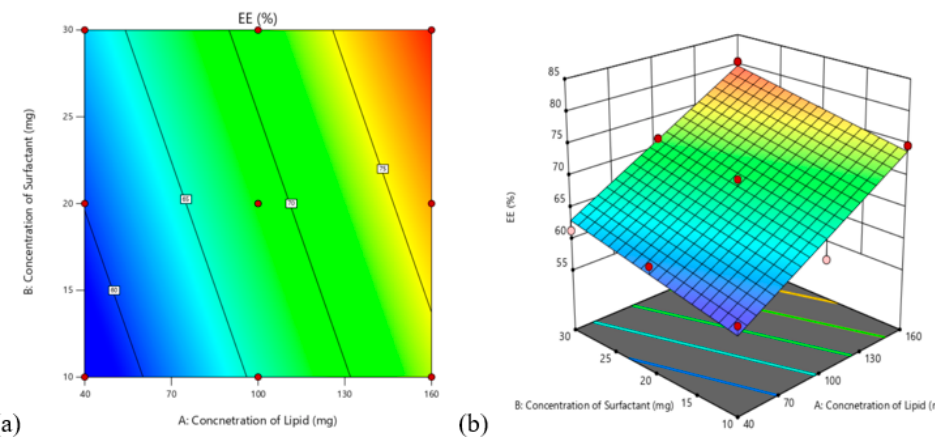
Figure 3. ( a ) 2D contour plot and ( b ) 3D response showing the effect of independent variables on response Y1.